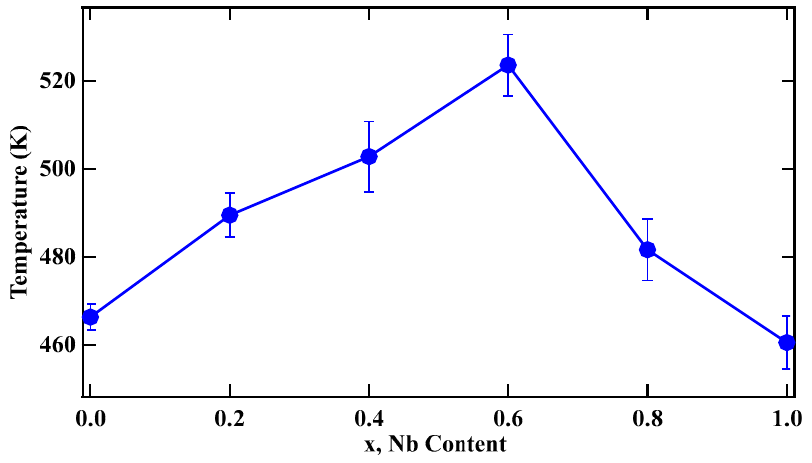
Figure 5. Curie temperature as a function of x , Nb content.